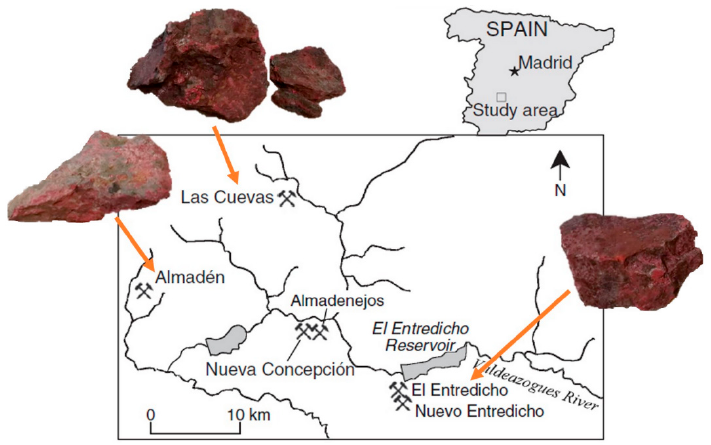
Figure 1. Map of the Almadén mining district and the location of the ore fragments. Adapted with permission fromGray et al. [14]. 2013. Elsevier.